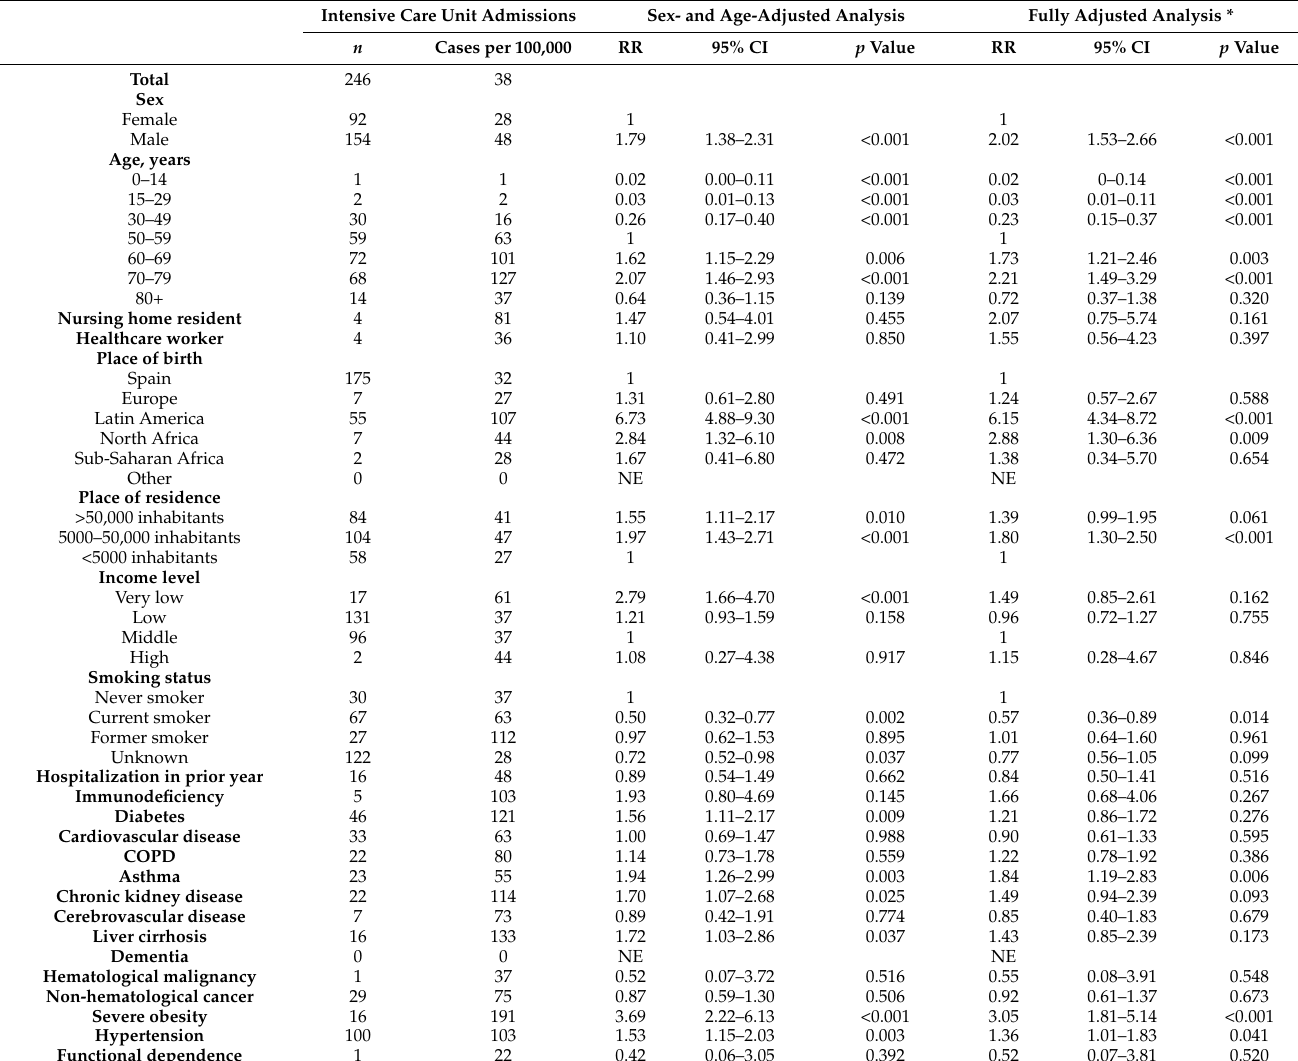
Table 3. Association between potential predictive factors and intensive care unit admission for COVID-19 in the general population